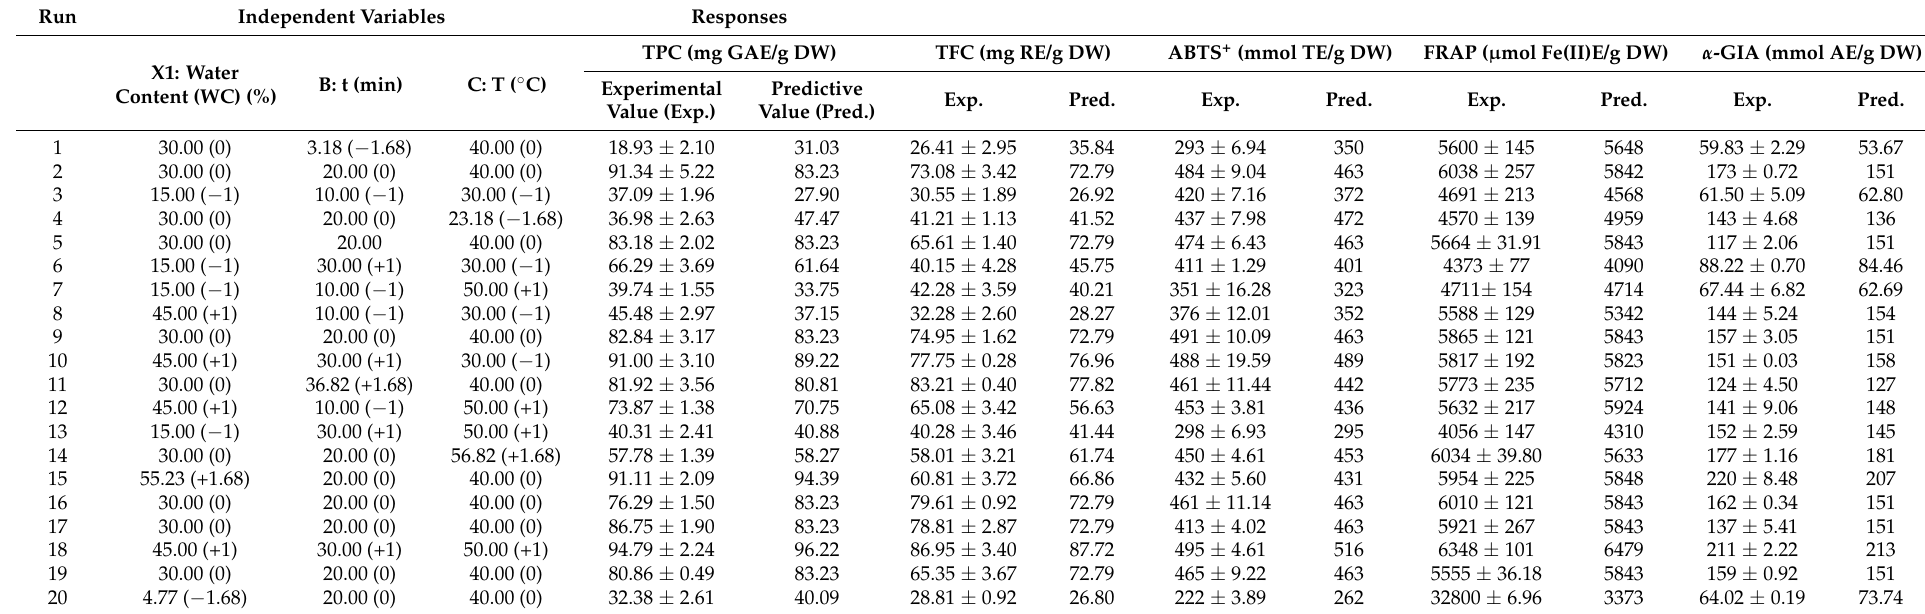
Table 2. Experimental and predicted results of the DLT extracts based on central composite design